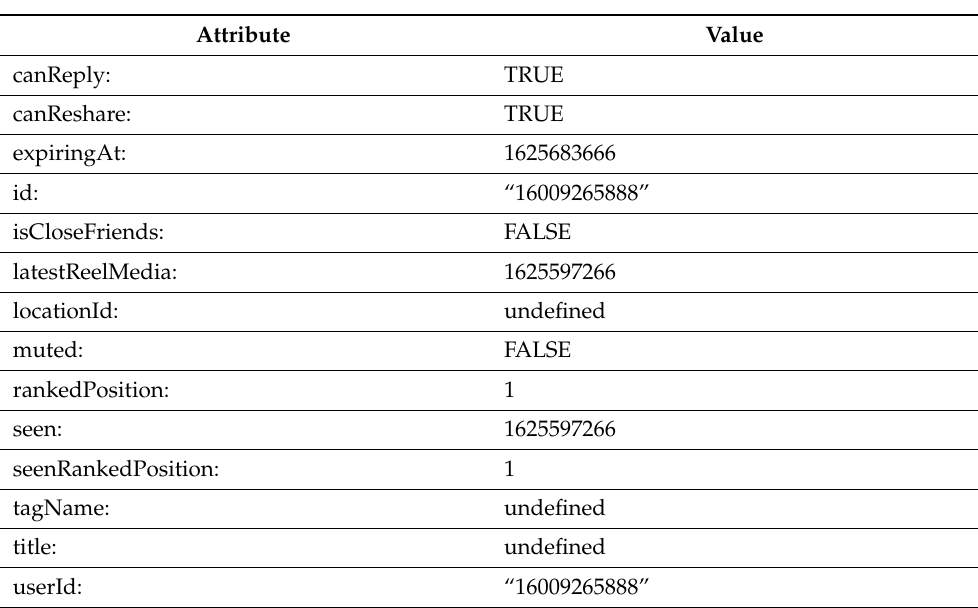
Table 13. Artifacts Found in stories.reels